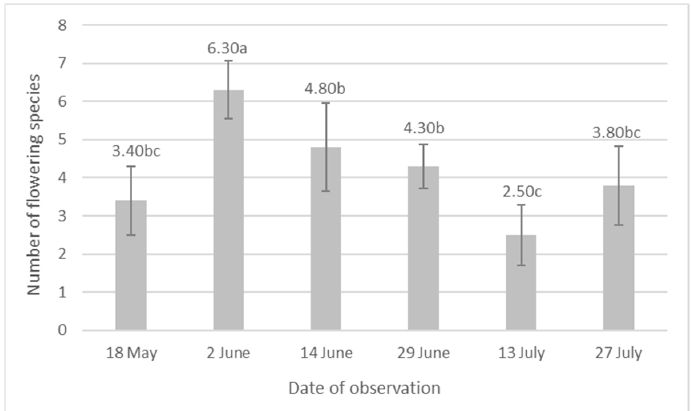
Figure 5. The average number of flowering species in the flower strip (regardless of the origin of plants) in the second year (2022) after the establishment of the flower strip in relation to the date of observation; averages marked with the same letters do not differ significantly at α = 0.05.